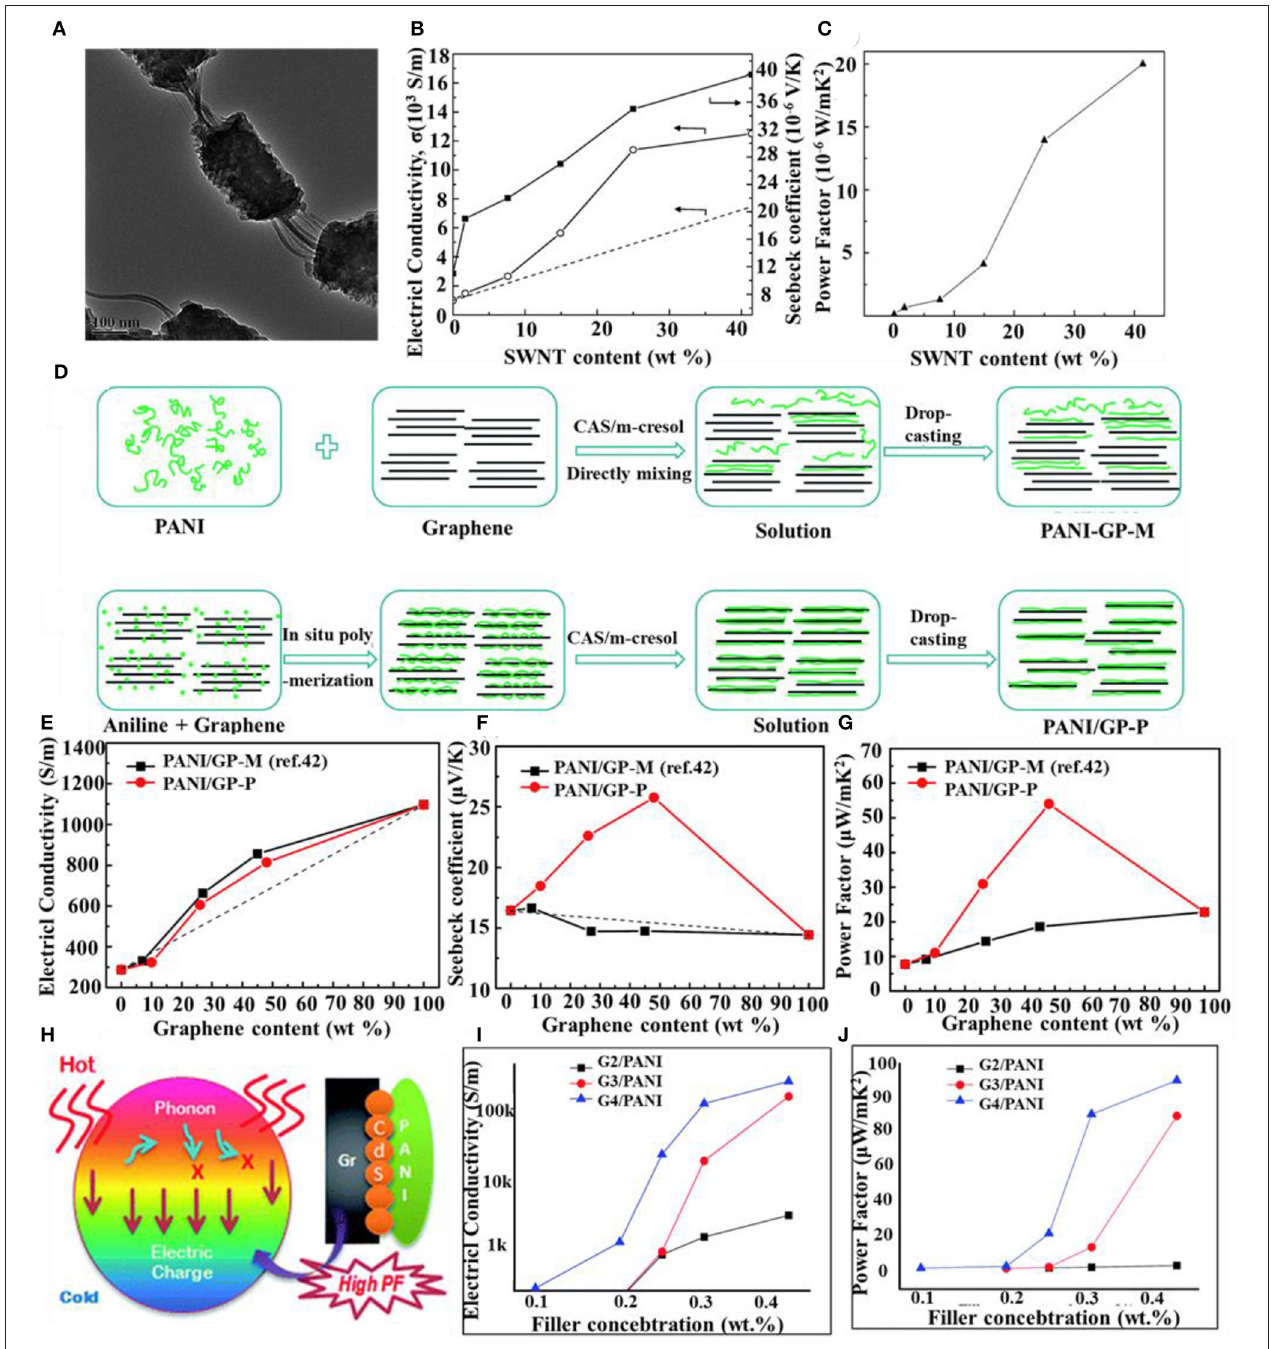
FIGURE 1 | (A) TEM image for SWNT/PANI composites containing 25 wt% SWNT, (B) Seebeck coefficient (closed squares), electrical conductivity (open circles), and (C) power factor (closed triangles) of SWNT/PANI composites containing different SWNT content. The dashed line is the calculated electrical conductivity based on the particle mixture rule. (D) Schematic illustrations of the synthesis procedure of (top) PANI/GP-M and (bottom) PANI/GP-P composite films and their corresponding (E) in-plane electrical conductivity, (F) Seebeck coefficient, and (G) power factor at room temperature with different graphene contents. (H) Schematic representation of RGO/CdS/PANI preparation nanocomposites for thermoelectric applications, (I) Seebeck coefficient, and (J) power factor vs. filler concentration. Reproduced with permission.